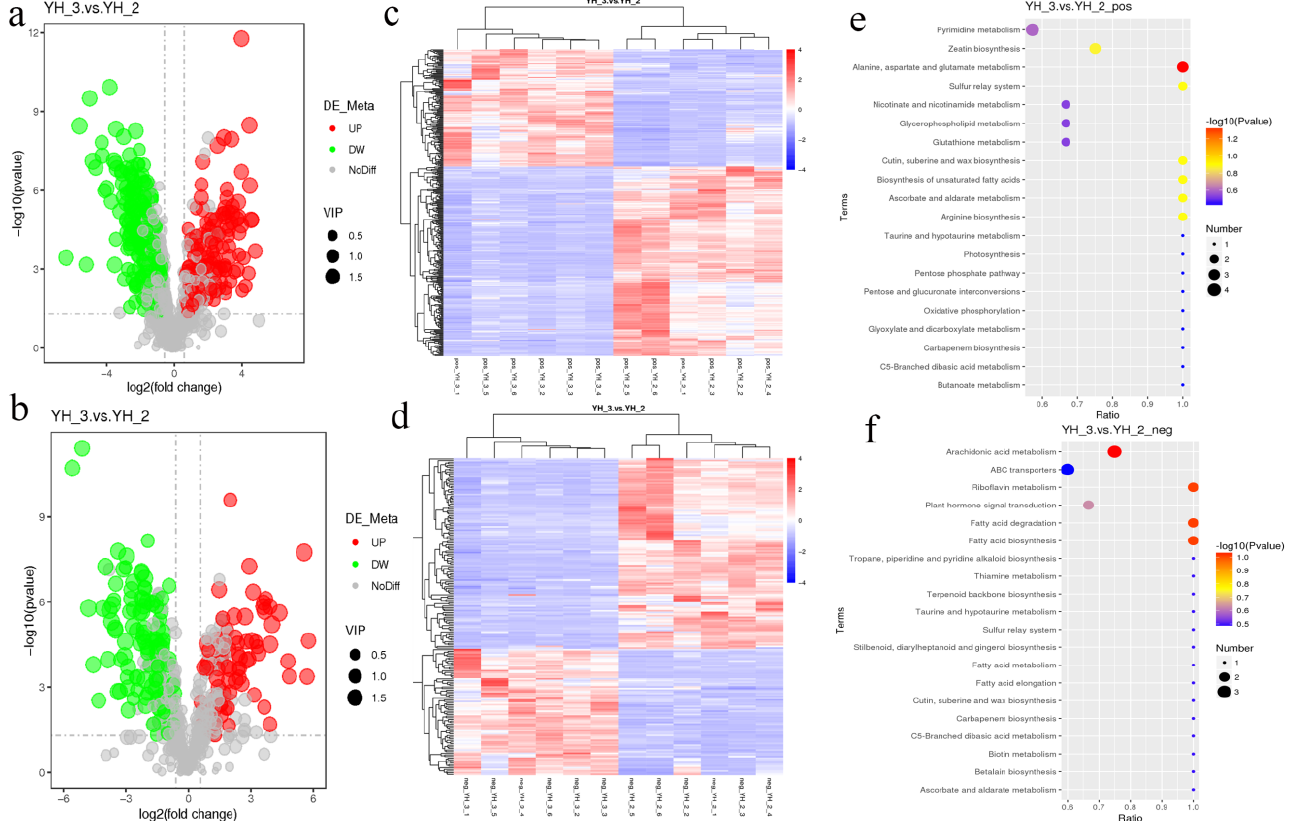
Figure 5. Differential metabolite accumulation analysis. ( a ) Volcano plot of differential metabolites in positive polarity mode. ( b ) Volcano plot of differential metabolites in negative polarity mode. Each point in the volcano map represents a metabolite, X-axis represents the logarithm of the quantitative difference of a certain metabolite in the two samples, and Y-axis represents the difference significance level (−log10p value). The green dots represent downregulated differentially accumulated metabolites, the red dots represent upregulated differentially accumulated metabolites, and the gray represents detected but not significantly differentially accumulated metabolites. YH_2: Desmodesmus sp. without sewage treatment; YH _3: Desmodesmus sp. with sewage treatment. ( c ) HCA of differentially accumulated metabolites in YH_3 vs. YH_2 (6 replicates for each sample) by posi- tive polarity mode. ( d ) HCA of differentially accumulated metabolites in YH_3 vs. YH_2 (6 repli- cates for each sample) by negative polarity mode. ( e ) Scatter plot of KEGG pathways enriched in positive polarity mode. ( f ) Scatter plot of KEGG pathways enriched in negative polarity mode. Ab- scissa in the figure is the ratio of the number of differential metabolites in the corresponding meta- bolic pathway to the number of total metabolites identified in the pathway. The greater the value, the higher is enrichment degree of differential metabolites in the pathway. The color of the point represents the p -value value of the hypergeometric test. The smaller the value, the greater is the reliability and statistical significance. The size of the point represents the number of differential me- tabolites in the corresponding pathway. The larger the point, the more is the number of differential metabolites in the pathway.